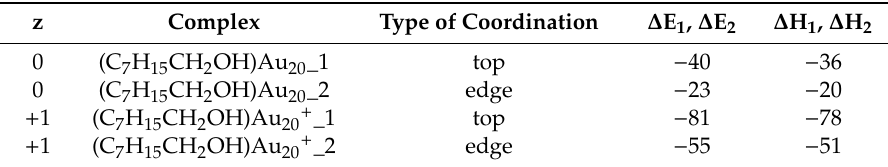
Table 7. Calculated energy change ( ∆ E in kJ / mol) and standard enthalpy ( ∆ H, kJ / mol) in the Reactions (R1) and (R2) of n -octanol with Au 20z cluster (z = 0, + 1).